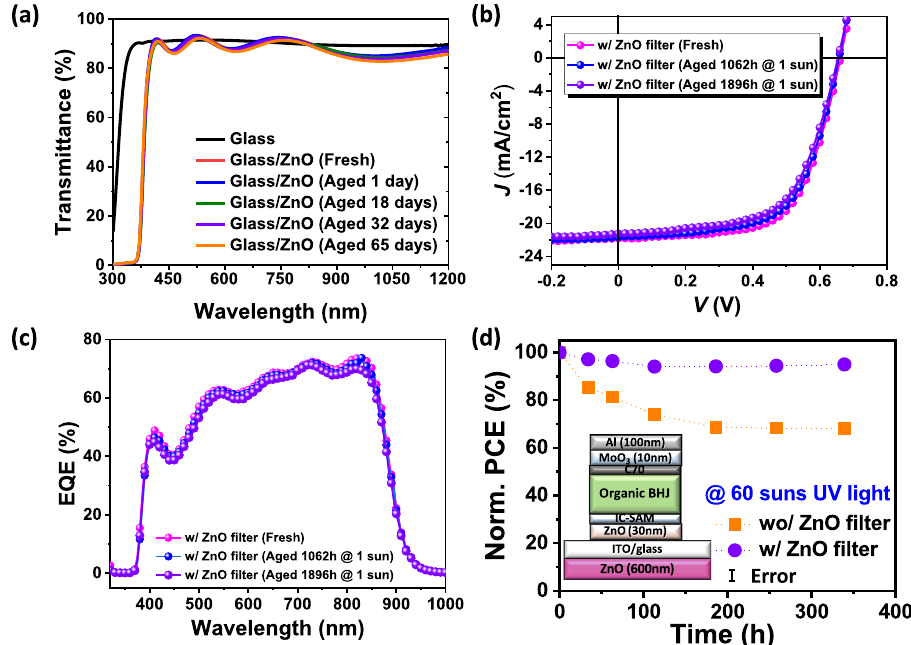
Fig. 5 Characterization of the ZnO UV fi lter. a UV-Vis absorption spectra of a ZnO UV fi lter plotted vs. aging time under simulated AM1.5 G 1 sun illumination in air over 65 days. b Current-density-voltage characteristics, and c external quantum ef fi ciency (EQE) spectra of fresh PCE-10:BT-CIC (1:1.5, w/w) devices with a ZnO UV fi lter, as well as the aged device under simulated AM1.5 G 1 sun illumination. d Normalized PCE plotted vs. aging time under ultraviolet illumination equivalent to 60 suns for more than 350 h with and without ZnO UV fi lter. The error bars indicate the 1 s.d. uncertainty of PCE